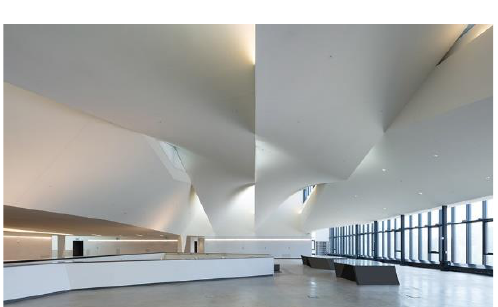
Figure 3. Harvard GSD. Harvard GSD.